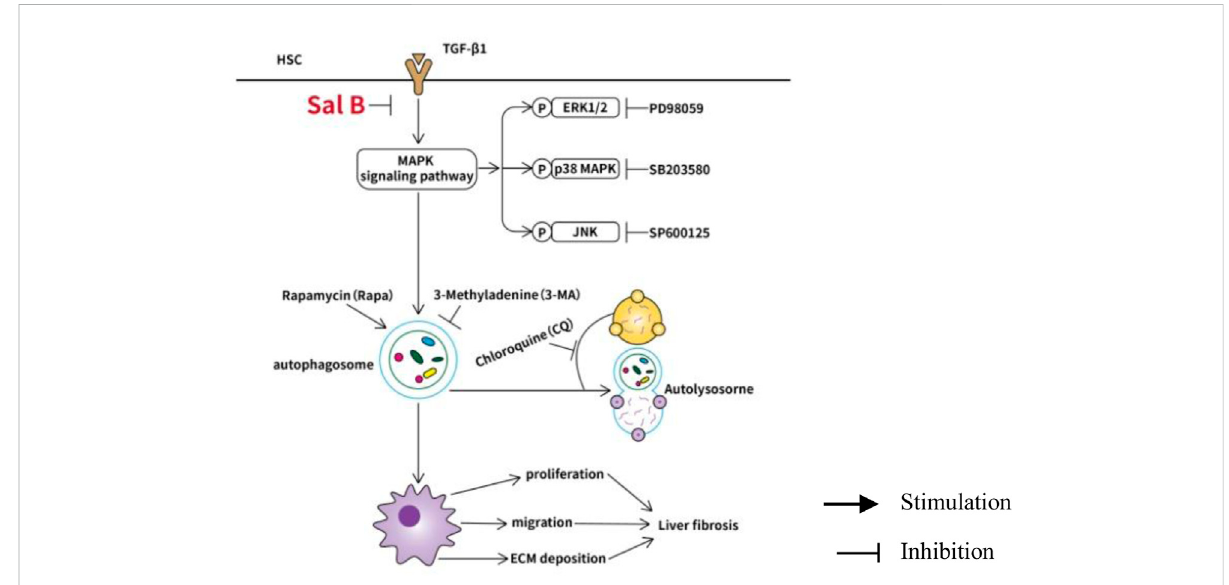
FIGURE 4 Working model of Sal B inhibits activation and autophagy of HSCs induced by TGF- β 1 through downregulating the MAPK